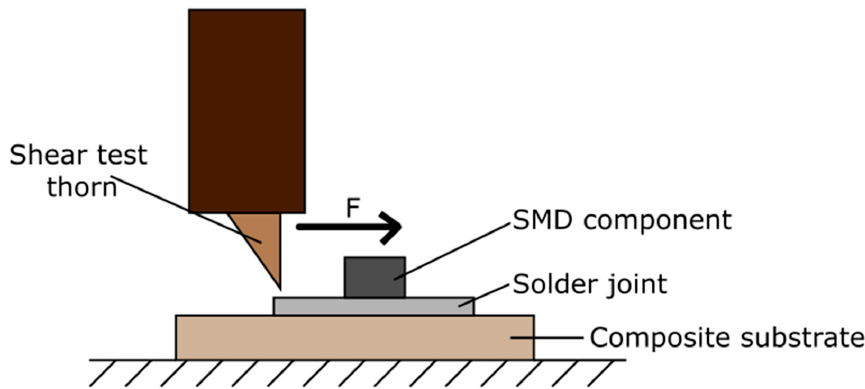
Figure 7. Schematic representation of shear test machine.